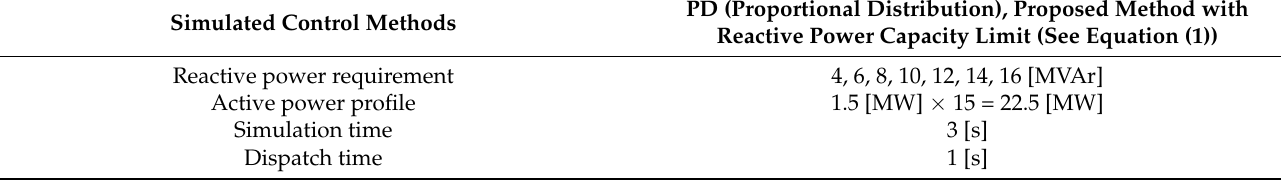
Table 2. Case study information .